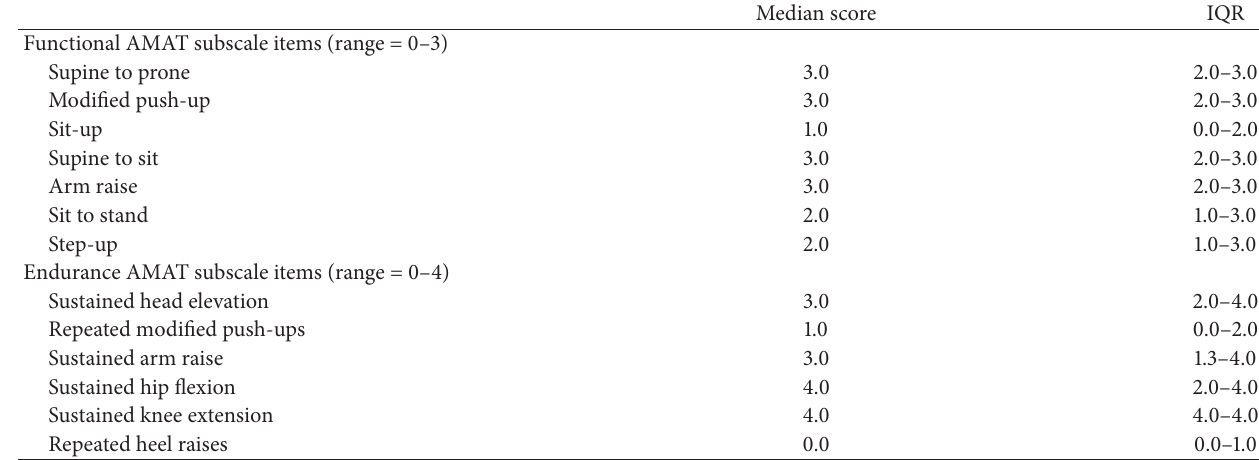
Table 2: AMAT item scores for patients with